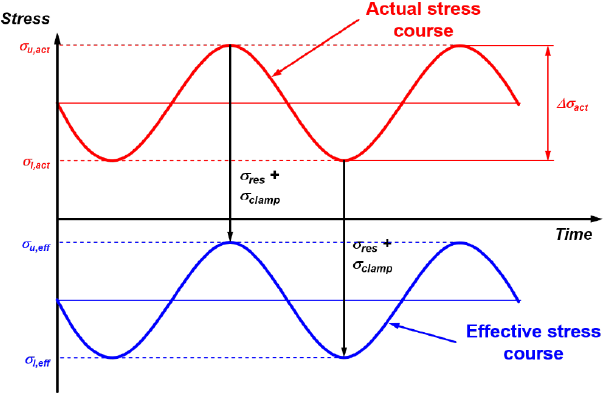
Figure 20. Shift of mean stress due to residual and clamping stresses.